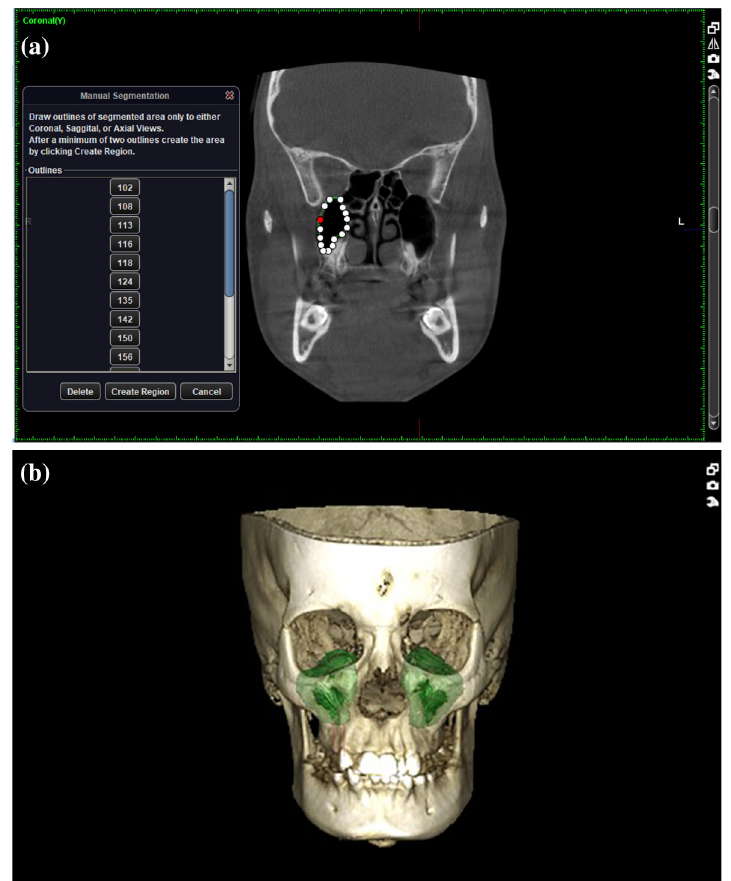
Figure3.a-Volumeofthemaxillarysinus(markingtheboundaryforeachCBCTslice).b-Constructed3Dview of sinus.